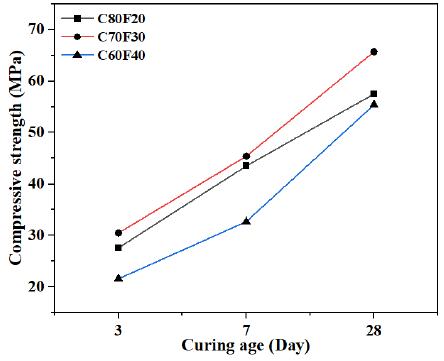
Figure 6. Group FA Compressive Strength.